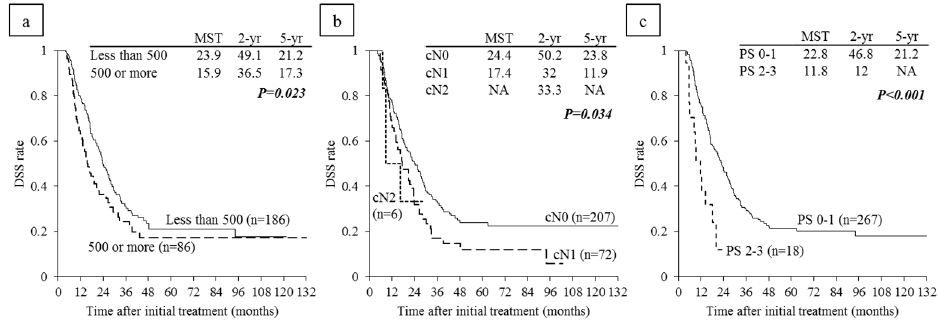
Figure 4. Disease-specific survival (DSS) curves according to ( a ) serum CA 19-9 level * before CRT in